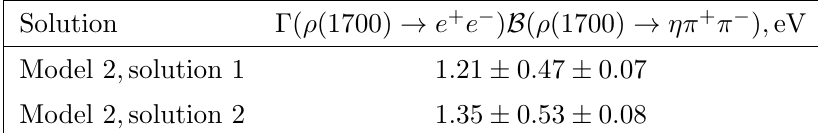
Table 6 . The (cid:0)( (cid:26) (1700) ! e + e (cid:0) ) B ( (cid:26) (1700) ! (cid:17)(cid:25) + (cid:25) (cid:0) ) obtained from the di(cid:11)erent (cid:12)ts, which correspond to solutions 1{2 of the second model. The (cid:12)rst uncertainty in each product is statistical, the last one is